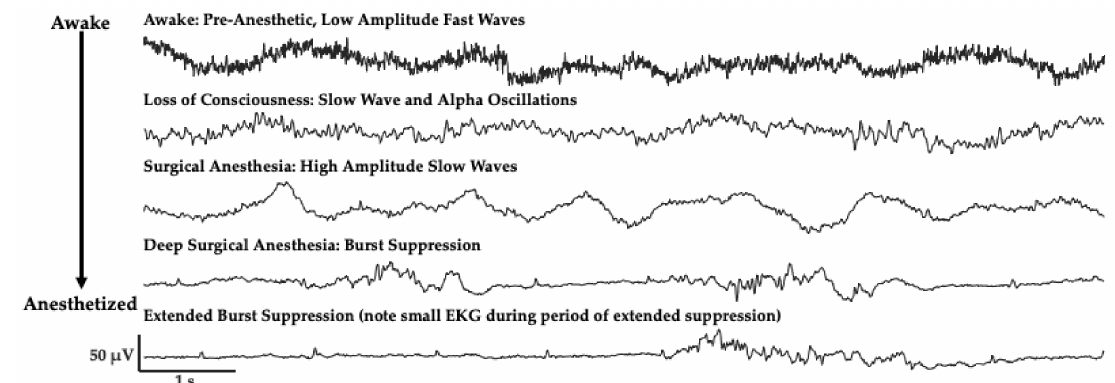
Figure 1. Patient electroencephalogram (EEG) signals change with increasing anesthetic depth when administered propofol, traces from frontal electrode site (F7) from a patient anesthetized with propofol. High frequency, low amplitude activity slows to include predominantly alpha and slow oscillations with anesthetic administration. Activity slows more to include a slow-wave dominant pattern, much like during natural sleep. At profound levels of unconsciousness (bottom two traces) a burst suppression pattern emerges, and suppressed periods extend as patients reach more profound levels of unconsciousness. Note the electrical activity from heart beats (electrocardiogram, EKG) which can be seen in the prolonged suppressed